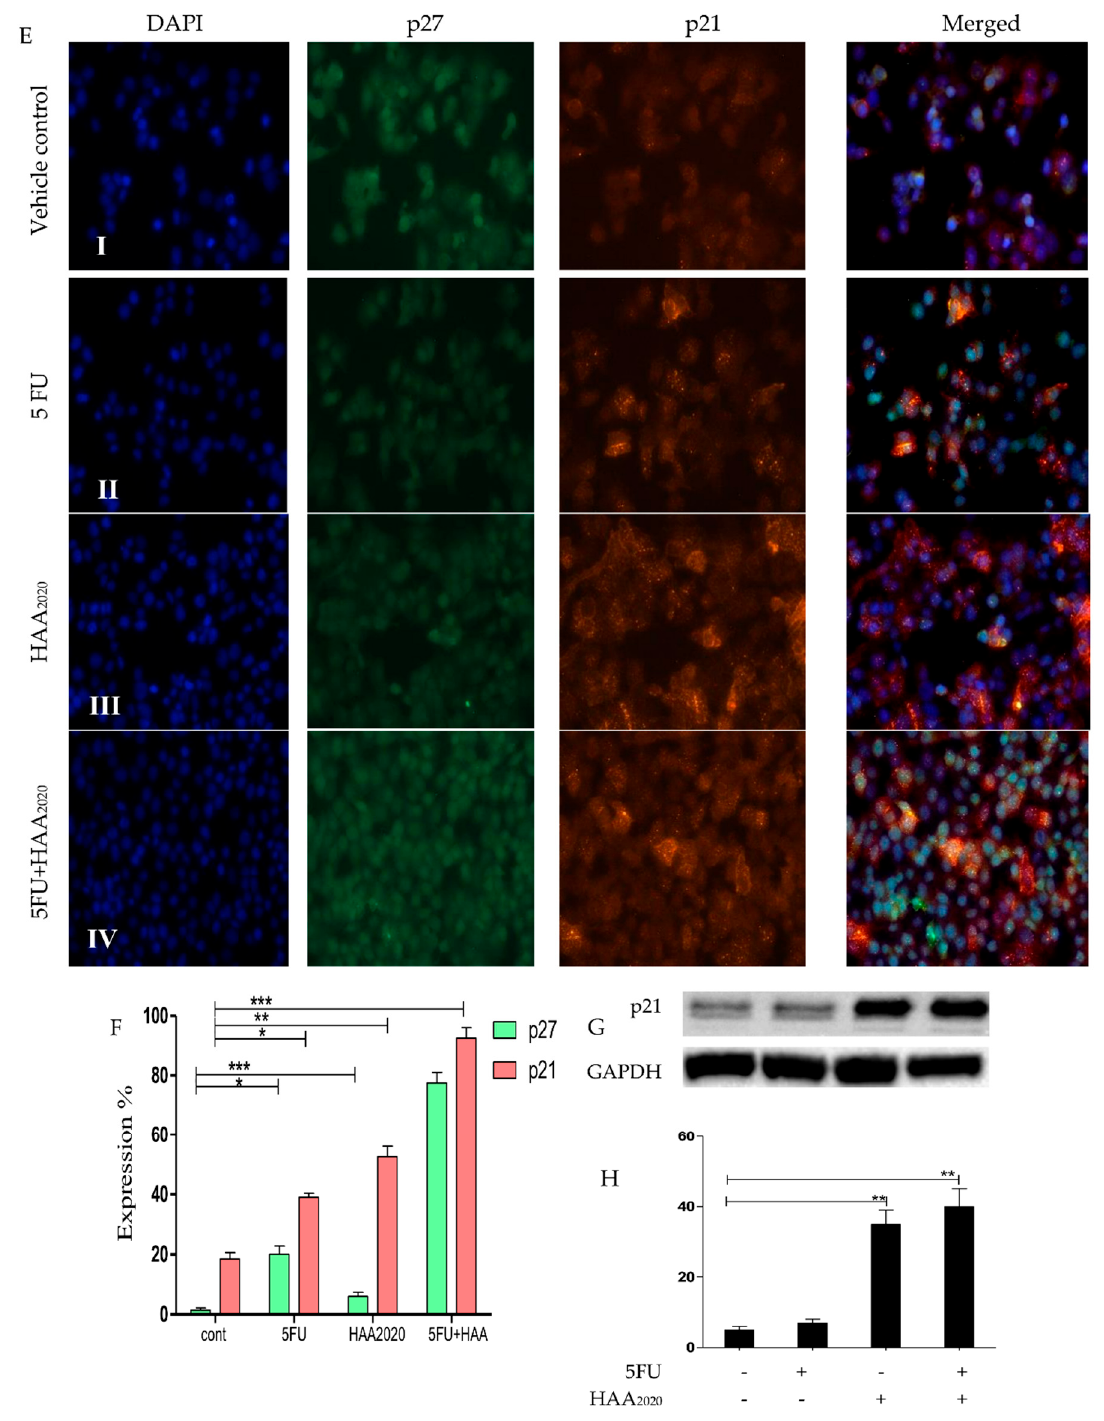
Figure 10. Detection of the immunofluorescence in ( A , B ) (expression %) : HT29 and ( E , F ) (expression %): HT29-5FU cells (EGFR and p27: green, caspase-8 and p21: red, stained with DAPI, 15 µm; 40× objective). ( I ) vehicle control, ( II ) cells incubated with 5FU, ( III ): cells incubated with HAA 2020 , ( IV ): cells incubated with 5FU and HAA 2020 for 72 h. Quantification of EGFR level amounts in HT29 cells by Western blotting ( C , D ). Quantification of p21 level amounts in HT29-5FU cells by Western blotting ( G , H ). Results in ( D , H ) represented the mean ± SD of the fold change percentage (%, Y axis) of the relative protein levels normalized to GAPDH, n = 2, ×2 independent experiments. p < 0.05 (*), p < 0.01 (**), and p < 0.001 (***) were considered significant.